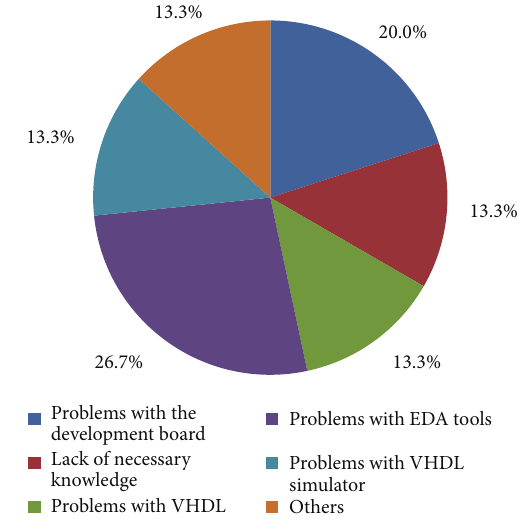
Figure 3: Percentage of student responses concerning the difficul- ties in concluding their